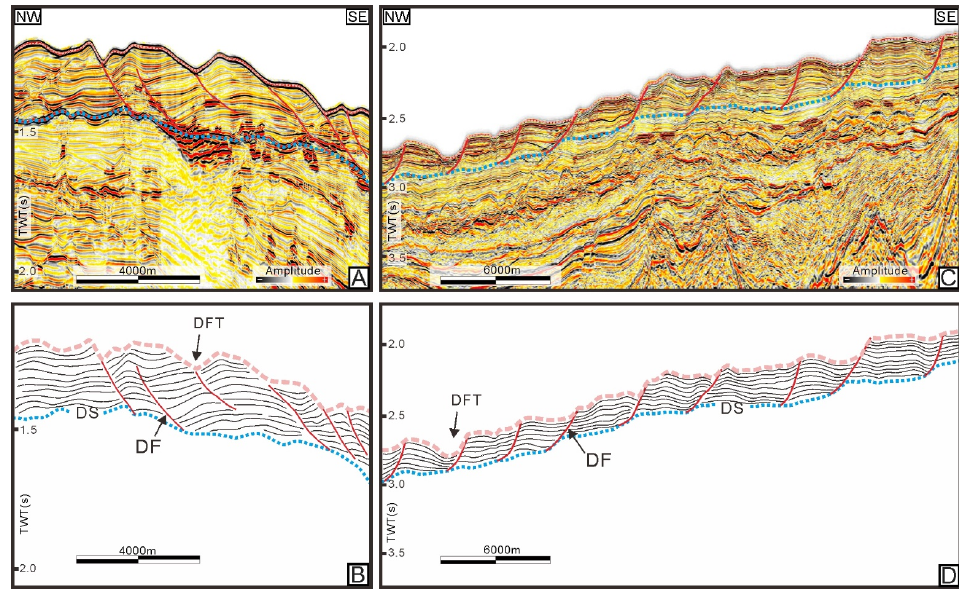
Figure 10. ( A , B ) Seismic profile and its geological interpretation showing the seemingly mounded topography on the seabed caused by submarine landslides in the Shenhu Sea in the northern South China Sea (profile quoted from [40]). ( C , D ) Seismic profile and its interpretation showing the seemingly mounded topography on the seabed in the Southern Slope (for location, see Figure 1). DS = detachment surface; DF = detachment fault; DFT = downfaulted trough; TWT = two-way traveltime. In this study, the mounded features were interpreted to result from the gravity gliding that was induced by tectonic activities. Firstly, detailed examinations of seismic data revealed that the uppermost layer of the Meishan Fm. was dismembered into a series of moderately deformed blocks by a number of faults with listric geometries which ceased downward to a unified surface (Figure 11A–C). The blocks resting upon the fault planes have shown clockwise rotation, with their internal beds perpendicular to the concave upward fault planes (Figure 11A–C). Secondly, soft-sediment deformation associated with gravity gliding might have occurred in the mounds (blocks) with their internal reflections showing convex-up fold structures and disturbed bedding (Figures 3–5 and 11A–C) [61]. Such phenomenon can be related to the rollover anticlines unique to the listric growth faults or associated with the local compressive stresses pervasive in slide blocks which cause internal beds to buckle [22,62,63]. These features are consistent with the gravity slide tectonics shown in some important examples documented previously [3,21,22,54–57]. It can be inferred that, after the end of Meishan deposition, the uppermost unconsolidated deposits composed of mudstones mixed with thin argillaceous siltstones glided along an underlying shear plane which is probably the top of deep lithified strata [3,15,20,21,39]. Finally, the unbalanced subsidence corresponding to the time equal to the top of the Meishan Fm. was likely to trigger the gravity gliding of sediments which created